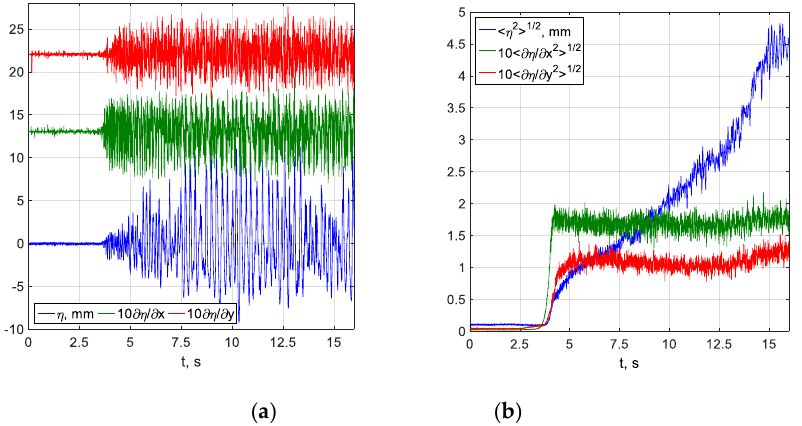
Figure 22. ( a ) Instantaneous surface elevation η (t) and surface slope components, ∂η / ∂ x ( t ) and ∂η / ∂ y ( t ) under wind accelerated from rest to the U = 8.5 m / s at fetch x = 220 cm; ( b ) corresponding ensemble-averaged values for U = 10.5 m / s and x = 340 cm.